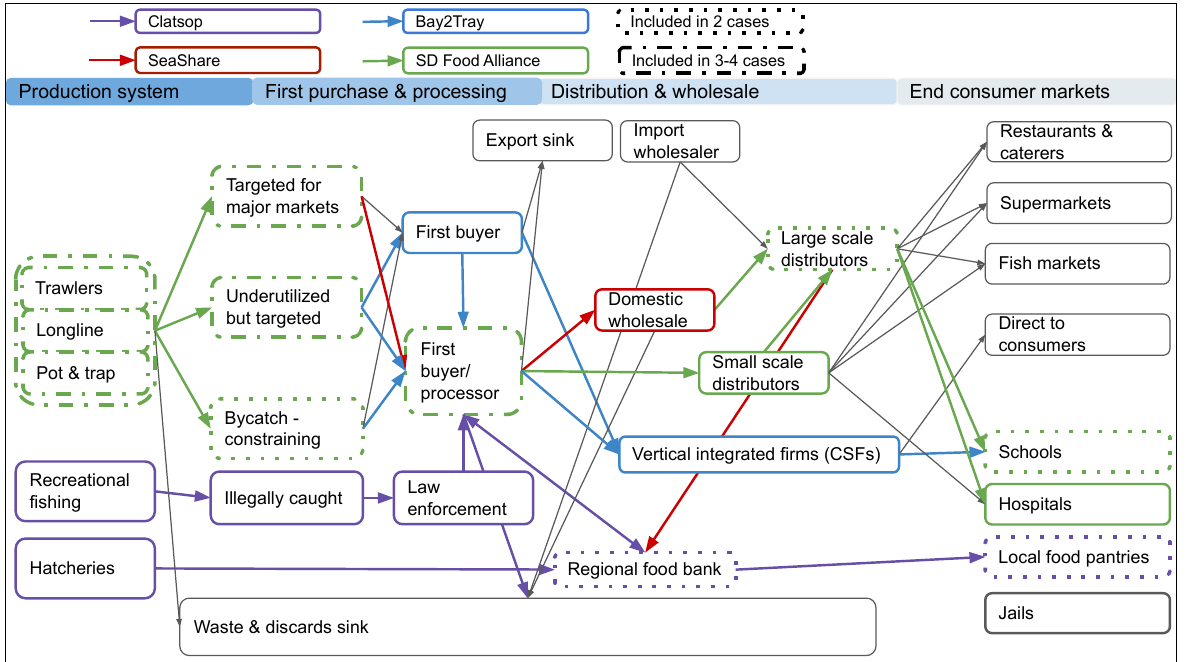
Figure 1. Conceptual Map of Entry Points of Seafood to Vulnerable Populations Used by the Positive Deviant